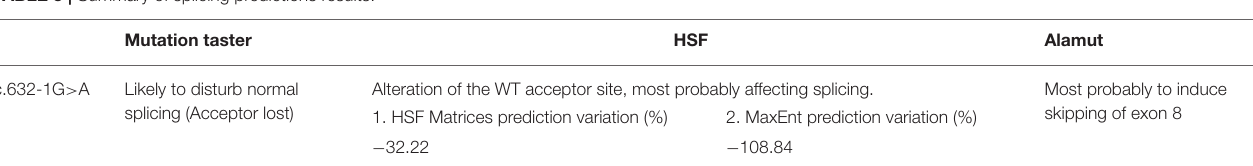
TABLE 3 | Summary of splicing predictions